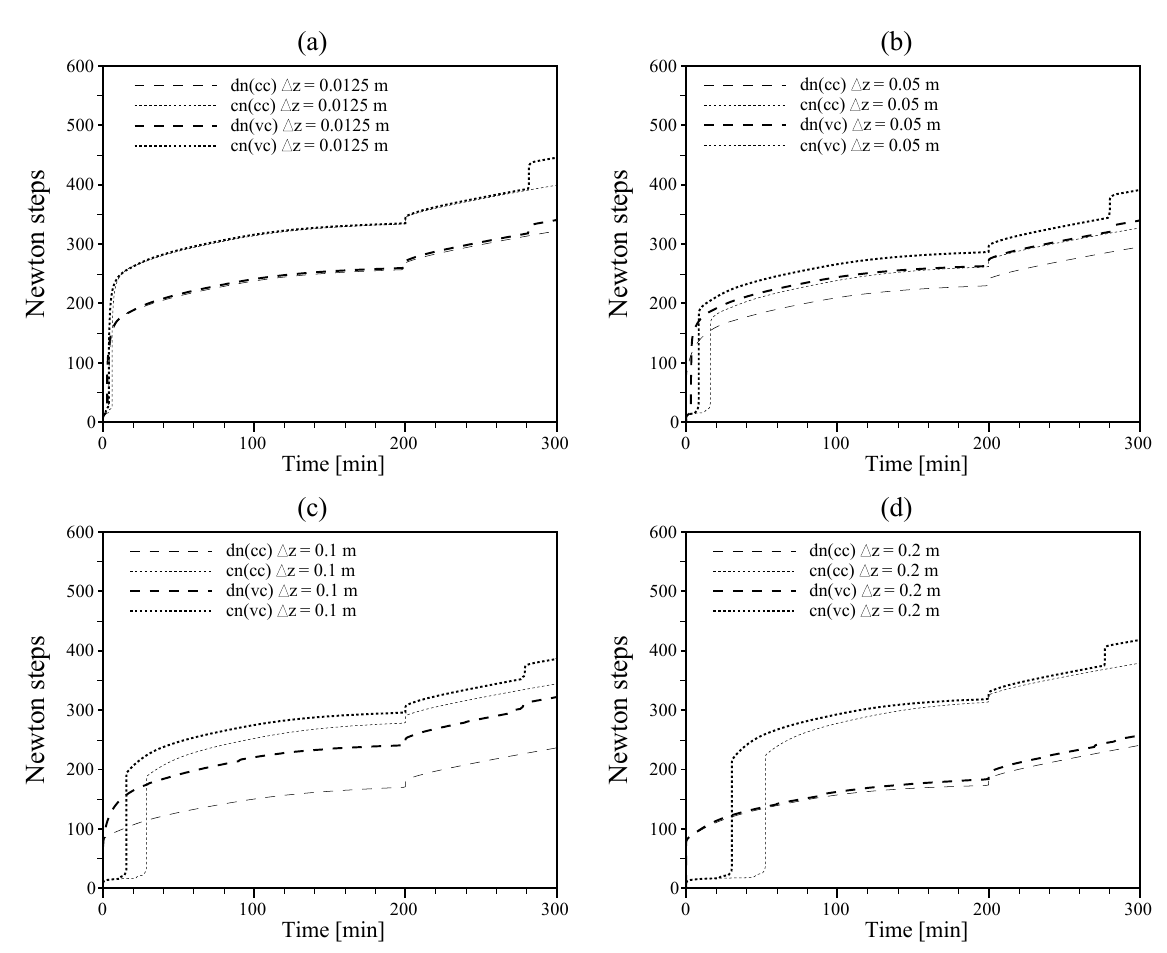
Figure 7. The total number of Newton steps for excess infiltration (second scenario) on a hillslope using different vertical discretizations.